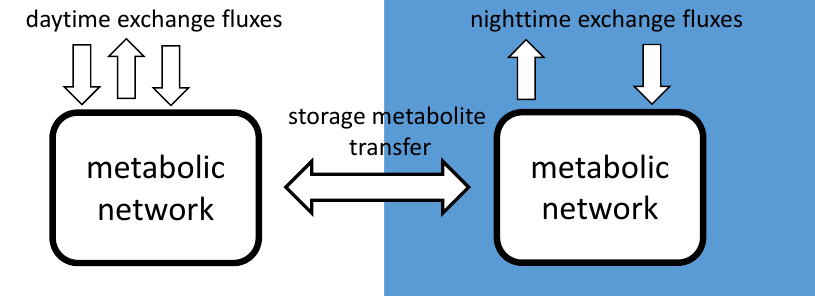
Figure 1. Schematic of the extended flux balance analysis (FBA) approach: the same metabolic network is simulated for both day and nighttime, while storage metabolites are used to transfer resources between the two